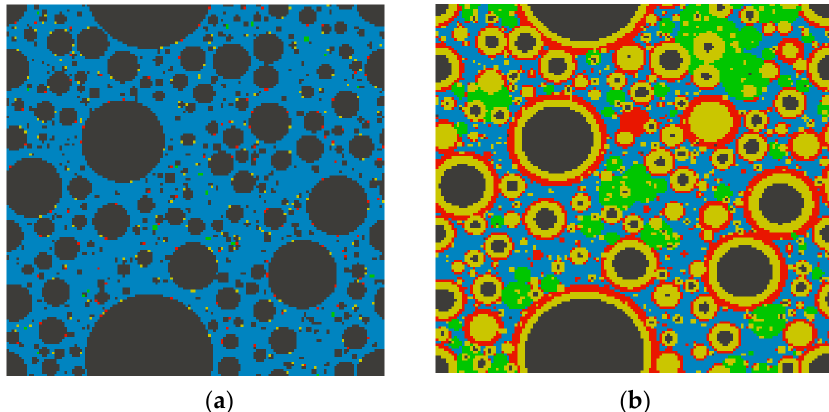
Figure 3. Microstructure formation of the cement paste in a 2D view: ( a ) after 1 h of hydration; ( b ) after 170 h of hydration (grey: unreacted cement grain; red: Inner C-S-H; yellow: Outer C-S-H; green: CH grain; blue: water or void).